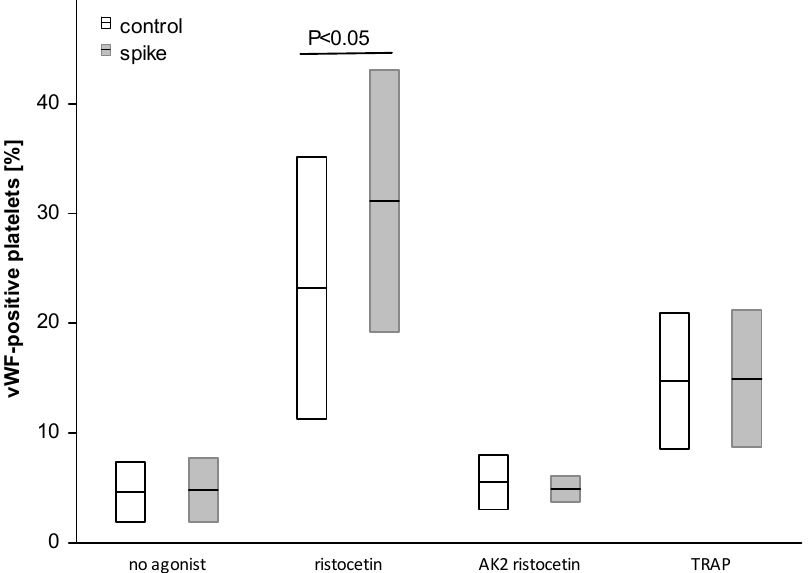
Figure 8. The binding of plasmatic vWF to the platelet surface in the presence of spike protein. Data are shown as mean ± SD. The vWF bound to platelets was identified with anti-vWF/FITC by using flow cytometry (more details in M&M). Spike protein significantly increased vWF binding to platelets compared to control in ristocetin-treated blood, p < 0.05 (bootstrap-boosted paired Student’s t -test, n = 13). Ristocetin (n = 13) and TRAP (n = 6) significantly increased the vWF-positive fraction of platelets in controls ( p < 0.05) and in spike-treated samples ( p < 0.01) compared to non-agonist samples. AK2 antibodies significantly reduced the vWF-positive fraction of platelets compared to ristocetin alone (AK2 ristocetin vs. ristocetin for control, p < 0.05, n = 6; AK2 ristocetin vs. ristocetin for spike, p < 0.001, n = 6). The significance of the differences between no agonist vs. agonist-treated samples was estimated with the ANOVA for repeated measurements and the post hoc Bonferroni test.